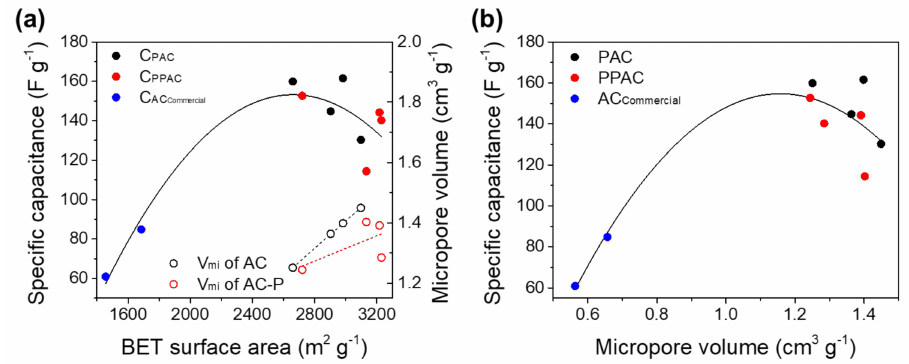
Figure 2. Effect of ( a ) BET surface area and ( b ) micropore volume on the specific capacitance of EDLC prepared by various activated carbon samples.